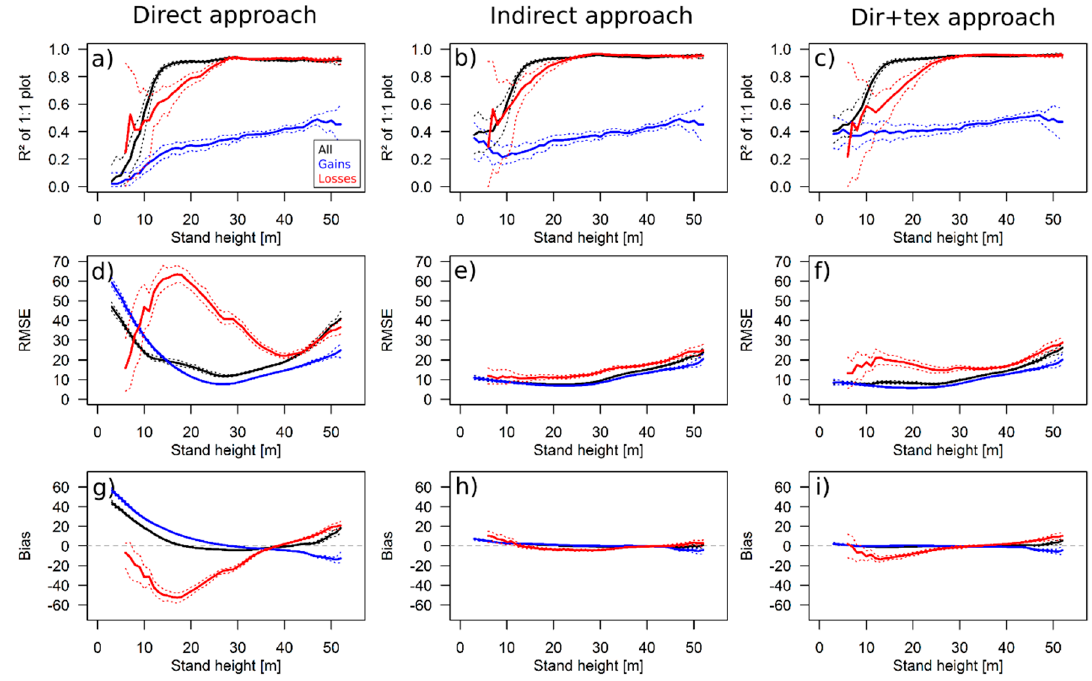
Figure 5. Prediction statistics of the three approaches plotted over stand heights. R 2 ( a – c ), root mean squared error (RMSE, d – f ) and bias ( g – i ) were calculated from 1000 samples in each stand height class. Solid lines represent the mean and dashed lines represent the minima and maxima of 100 bootstrapping replicates. Sampling was done using the full dataset (“All”, black ) and using exclusively stands with positive (“Gains”, blue ) or negative (“Losses”, red ) height changes, respectively.